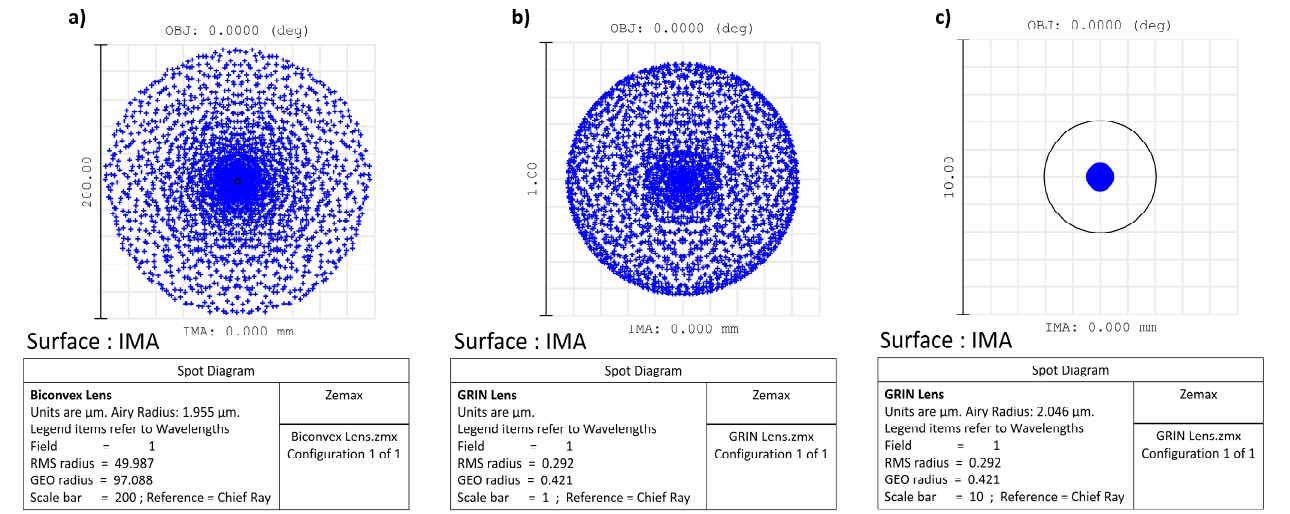
Figure 9. The diameter of the spot projected onto the image plane for ( a ) biconvex lens; ( b ) GRIN lens; ( c ) airy disc for the GRIN lens.